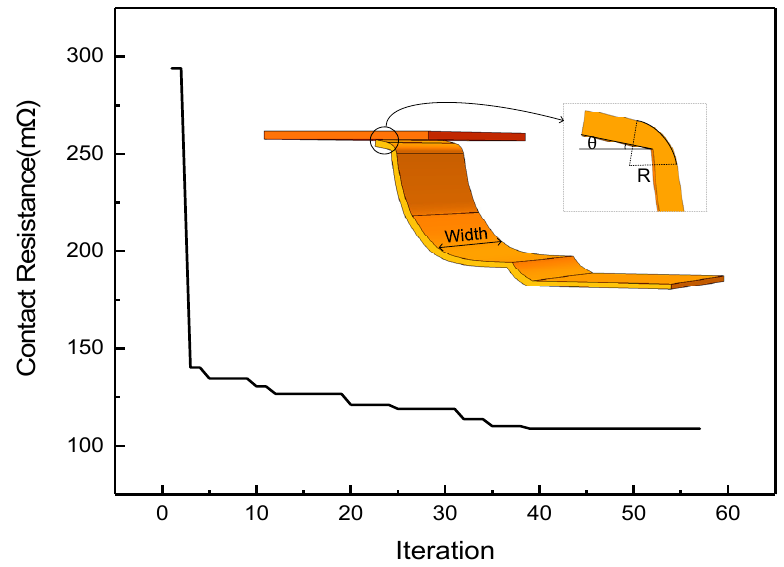
Figure 8. Schematic of convergence process. Table 2. Parameters of the initial and optimized CMIs.